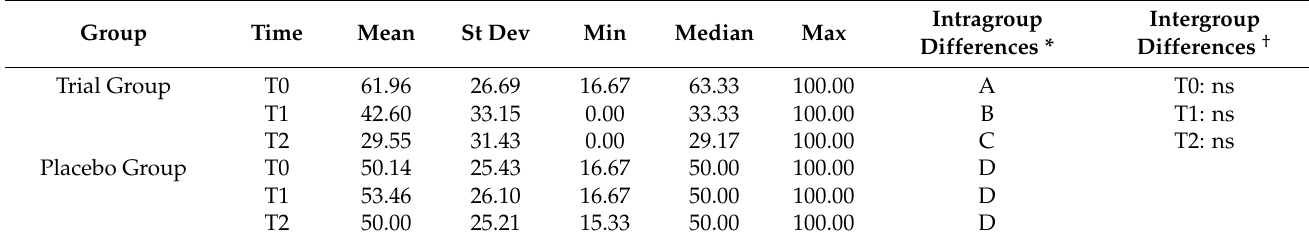
Table 4. Descriptive statistics of Bleeding on Probing measurements (BOP%).